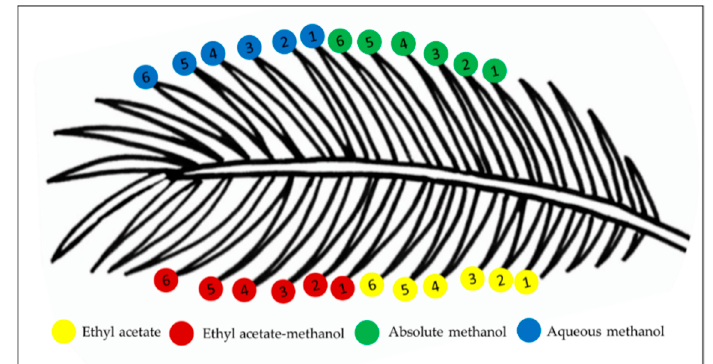
Figure 7. Illustration of sampling method of the 24 mature leaflets from 17th oil palm frond of Elaeis guineensis Jacq. Six leaflets were sampled for each solvent system used for extraction.